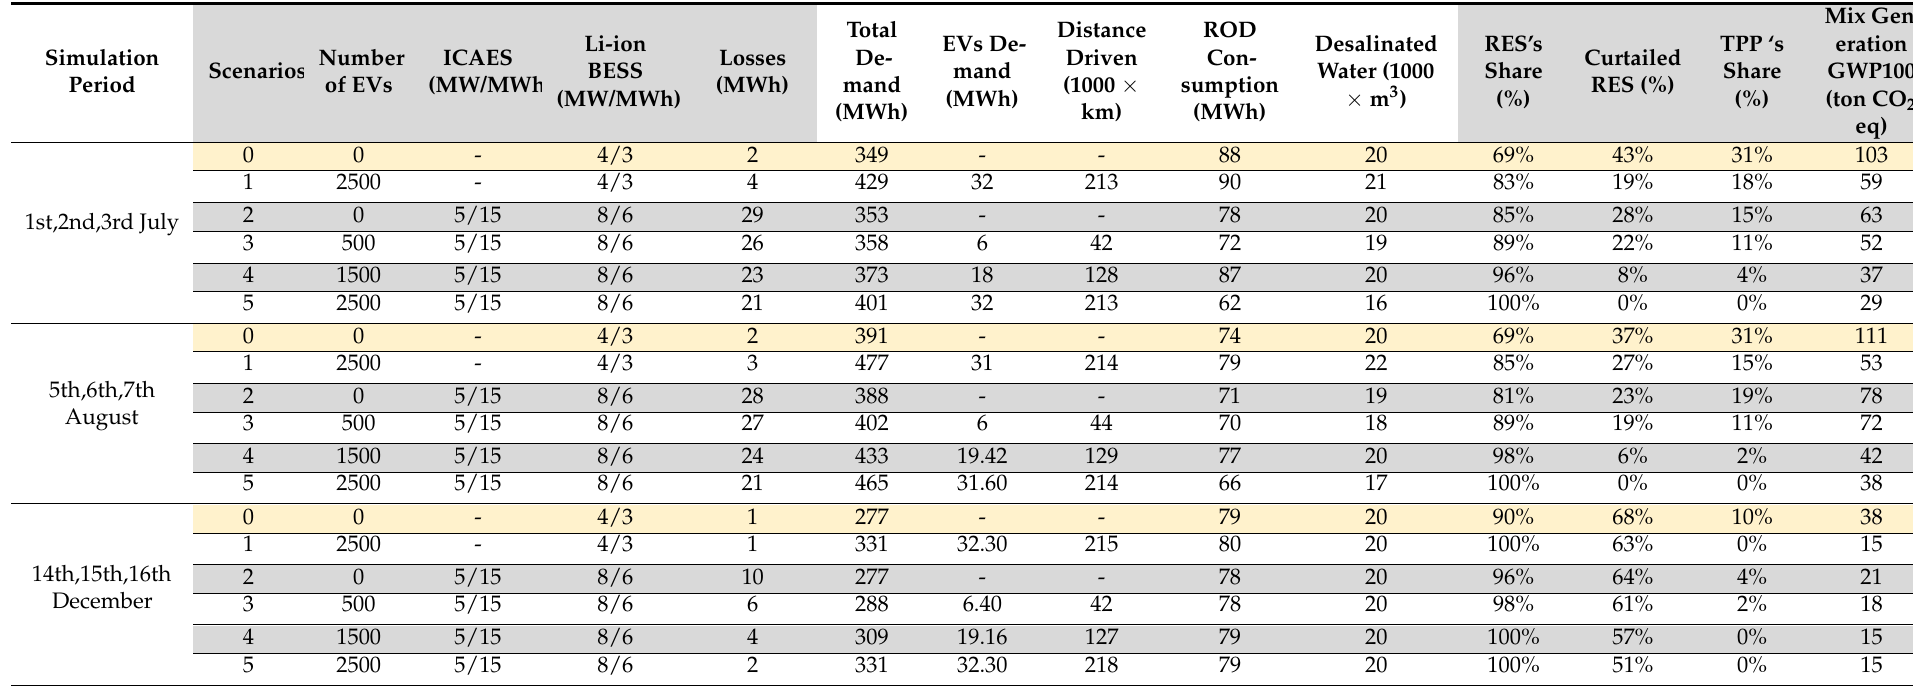
Table 4. The obtained result for three days of optimized, integrated management of resources under high-RES penetration on the Porto Santo’s power